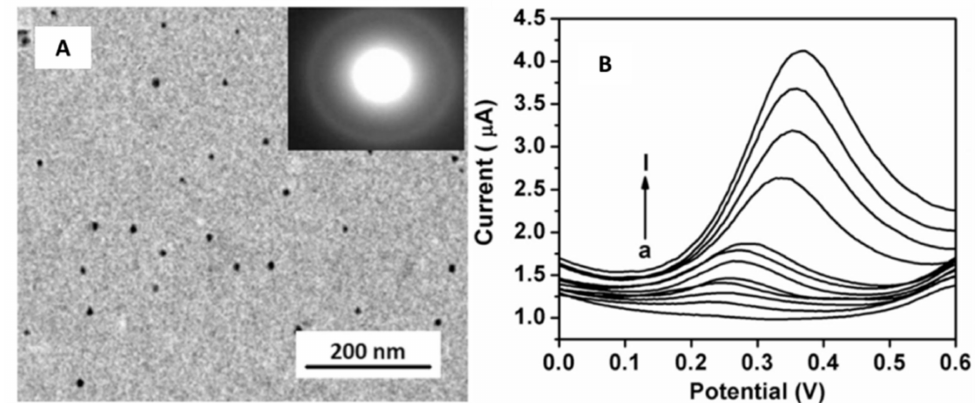
Figure 2. ( A ) TEM micrograph of GR/CD/Pt composite. ( B ) CV response of cysteine at the SPE modified with the GR/CD/Pt in a concentration range of 0.5–170 µ M in 0.1 M PBS buffer pH 7.4. Reproduced with permission of Singh et al., Journal of Electroanalytical Chemistry; published by Elsevier, 2018 [39].